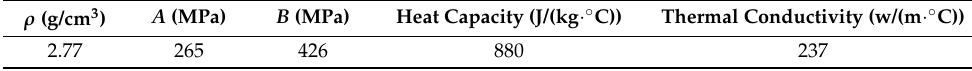
Table 1. Constitutive parameters of